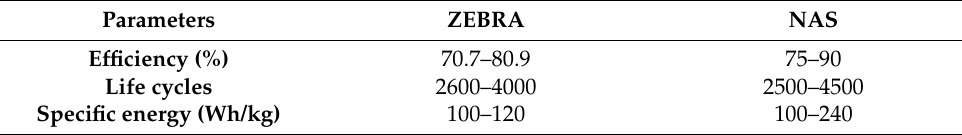
Table 6. Comparison of the main technical parameters of the different molten salt batteries.